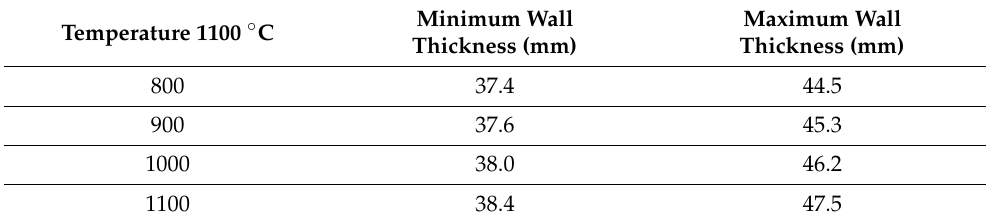
Table 2. The maximum and minimum wall thickness of cylinders after spinning at different tem- peratures.